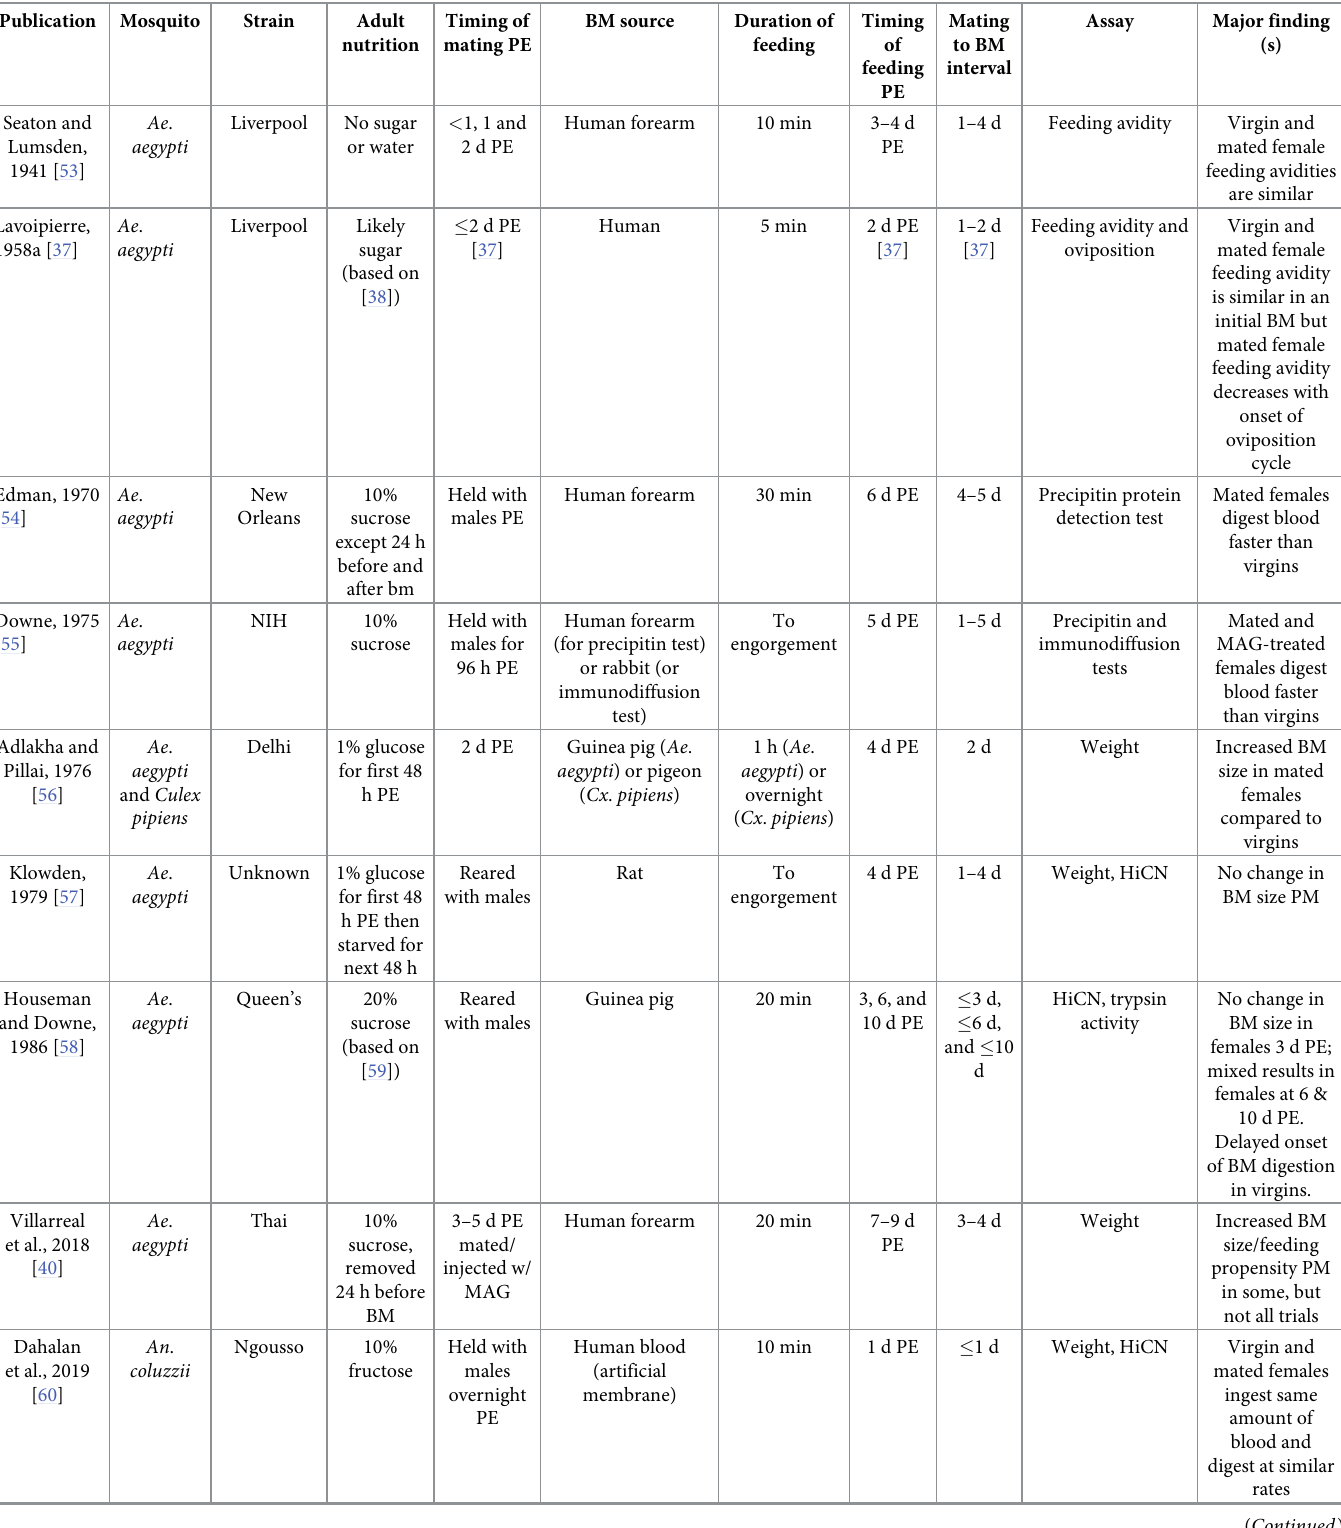
Table 1. Summary of previous studies on the effect of mating on blood-feeding avidity, digestion, and intake in mosquitoes. Publication Mosquito